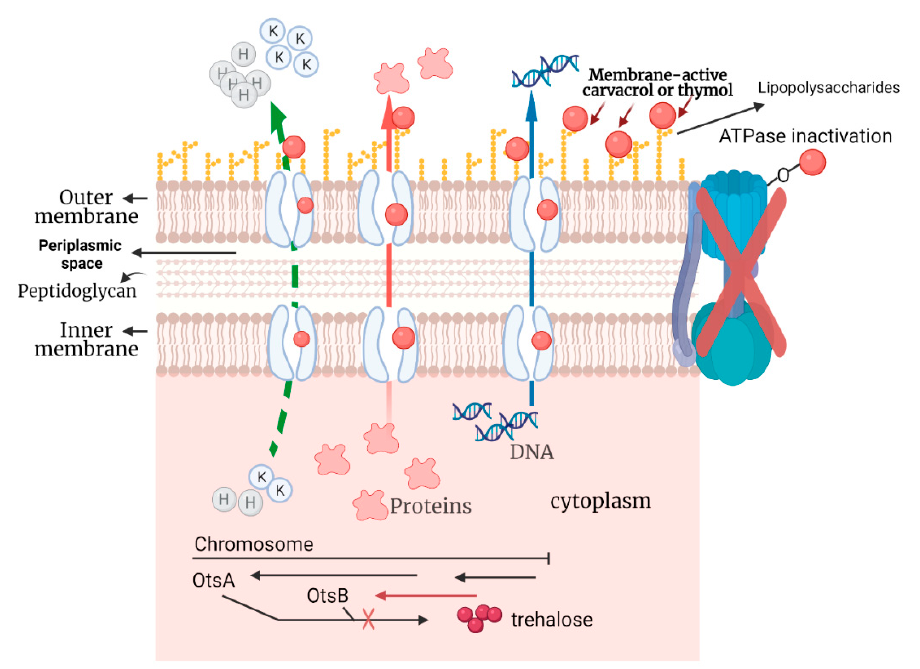
Figure 10. Proposed anti-desiccation resistance mechanisms induced by carvacrol or thymol against desiccation-resistant Salmonella Tennessee. The illustration was created using Biorender.com (accessed on 22 December 2021).